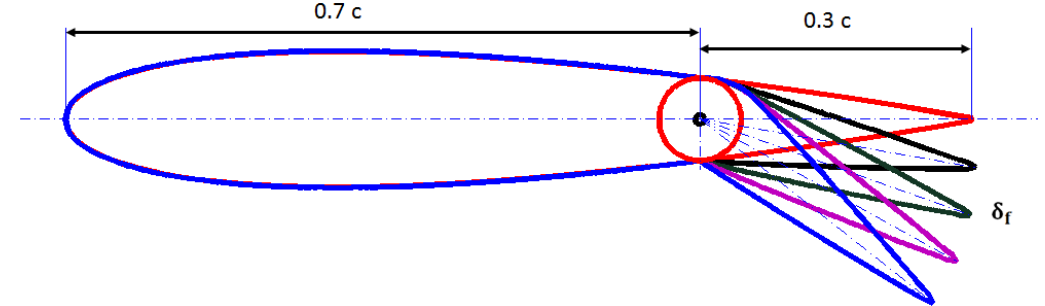
Figure 1. Geometry of the NACA 0015 airfoil with a 30% trailing edge deflected flap.